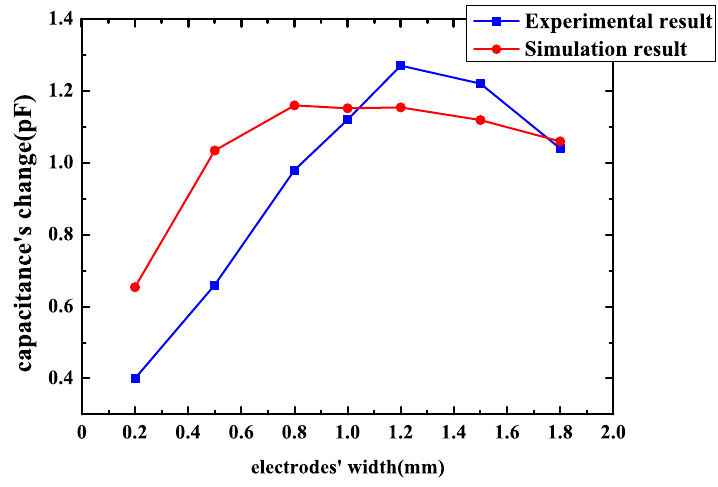
Figure 15. Experimental results of spiral pattern sensor capacitance’s change with electrodes’ width. Table 6. Parameters of FEF (fringing electric field) sensors in Figure